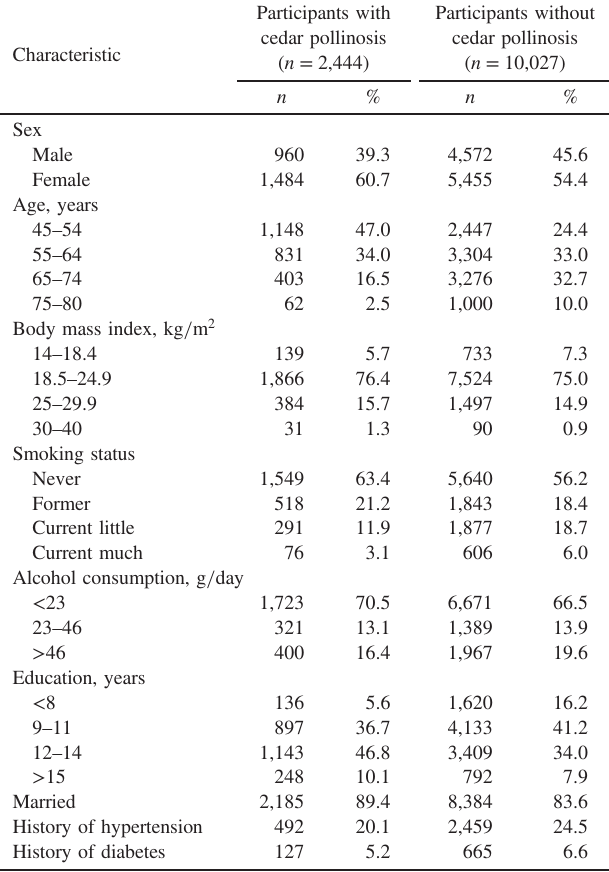
Table 1. Characteristics of the Takayama cohort participants at the time of the 2002 second survey